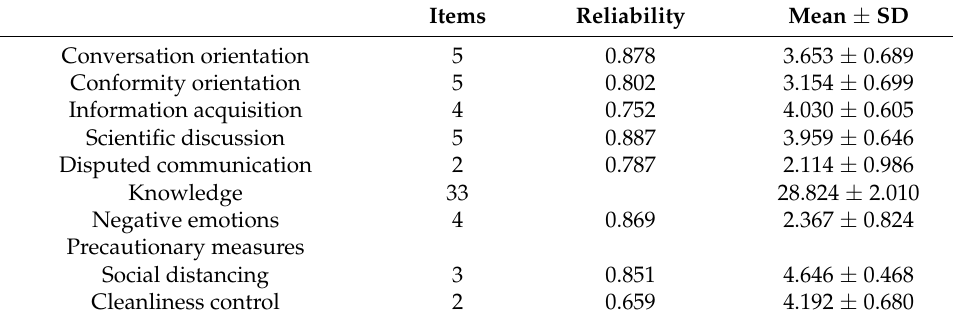
Table 1. Description of